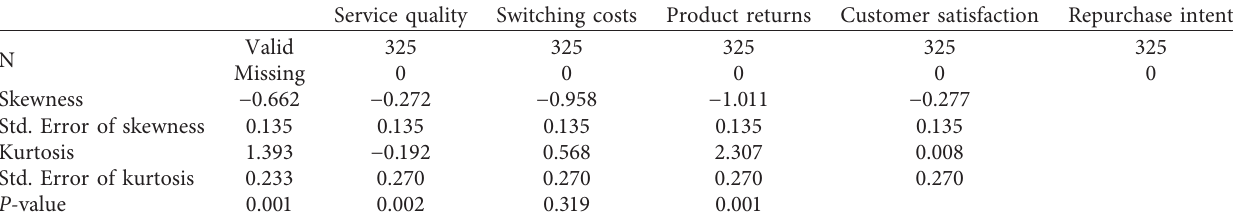
Table 4: Frequencies of the study